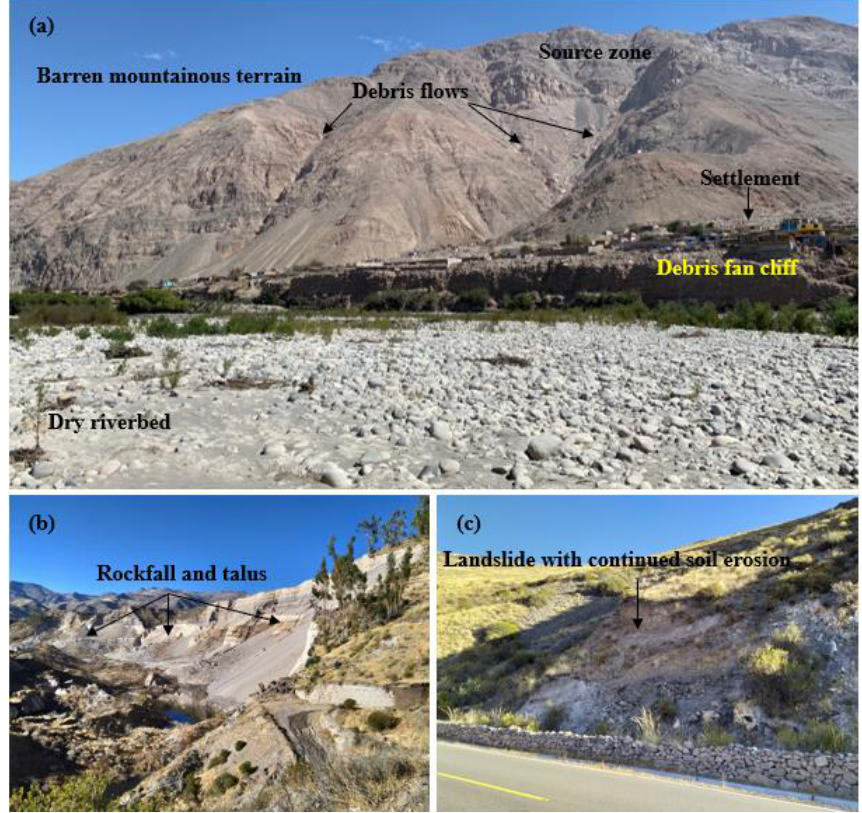
Figure 2. Field photographs of the study area. ( a ) Typical river valley setting in the Apalo region, showing the canyon in the center of the photo that produces regular debris flows, and the shadowed cliff across the photo is a debris flow fan that has been cut by the river running in front of it. ( b ) Extensive rockfall and talus accumulation in the Cabanaconde area has formed fan deposits at the base of the extensive rock cliffs in the center of the photo. ( c ) The Chivay area shows a vegetation pattern in a higher altitude region where dryland grasses dominate the hillsides with isolated bushes. Bare ground in the center of the photo corresponds to a small landslide with continued soil erosion of the loose